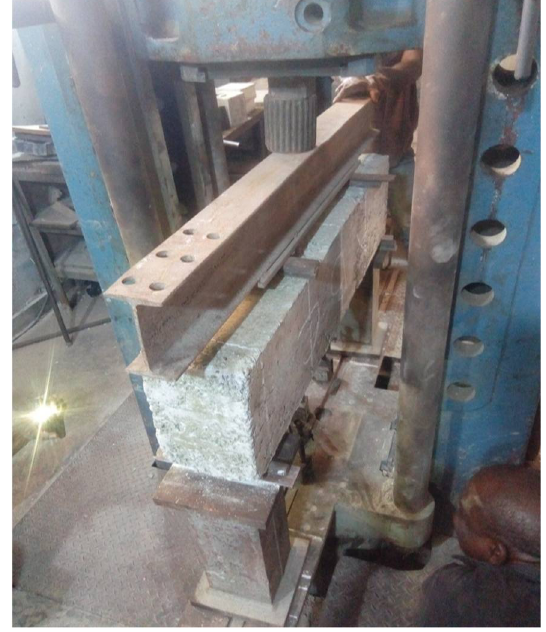
Figure 8. Testing of a beam using an ultimate testing machine.